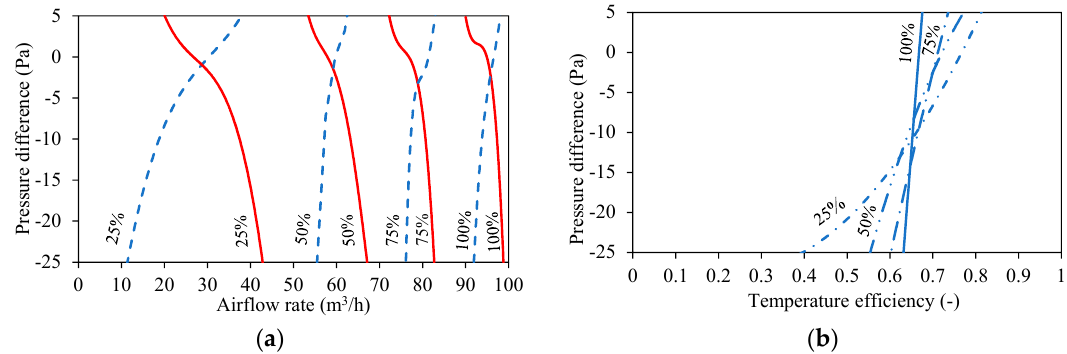
Figure 11. ( a ) Measurement based fan performance curves of room-based ventilation units with recuperative cross-flow plate HEX; ( b ) Measurement based temperature efficiencies of room-based ventilation units with recuperative cross-flow plate HEX.